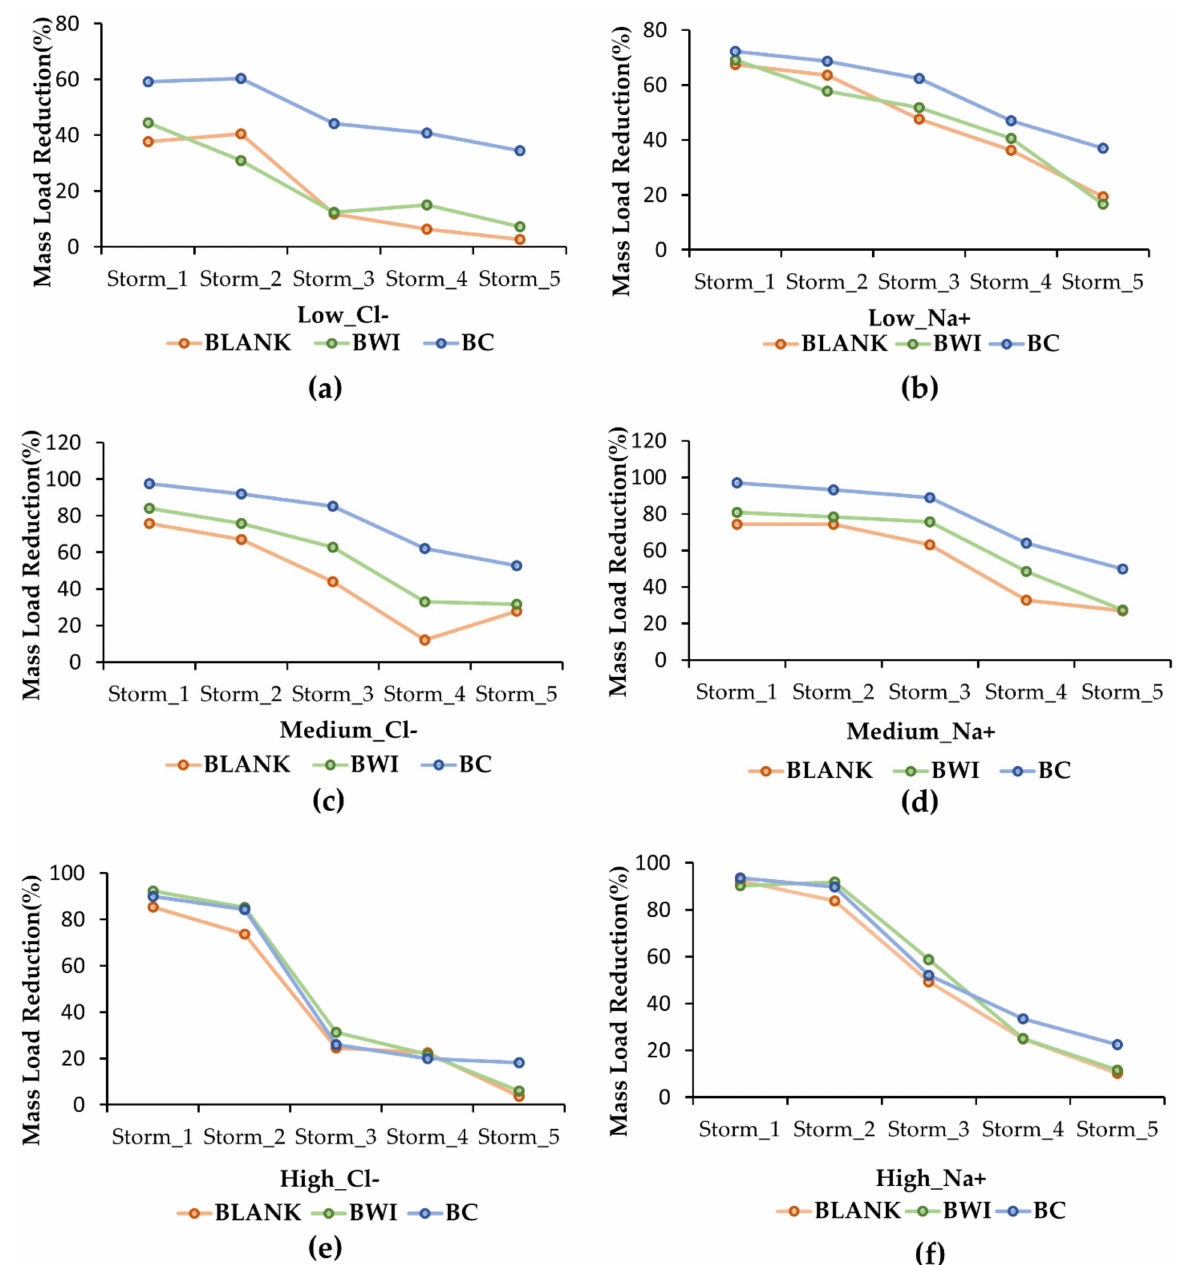
Figure 10. Mass load reduction trends for chloride and sodium ions for each of five storms. The flow volumes for each storm are given in Table 2 and are based on loadings observed at the Lorton Road BR field site (blank: no plants; BWI: Blue Wild Indigo; BC: Broadleaf Cattail). ( a – f ) depict different Cl − or Na +